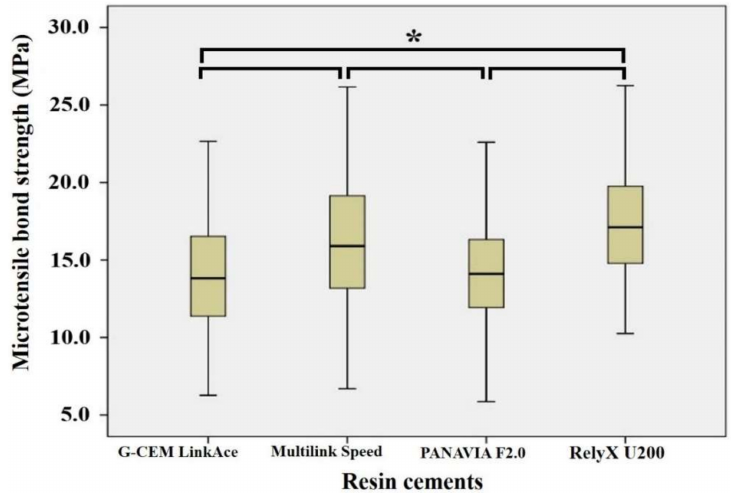
Figure 4. The statistical analysis on resin cement regardless of the surface treatment. The highest mean MPa value was shown with the application of RelyX U200 and there was a statistically significant difference between G-CEM LinkAce and PANAVIA F2.0, but no statistically significant difference shown with Multilink Speed. *: statistically